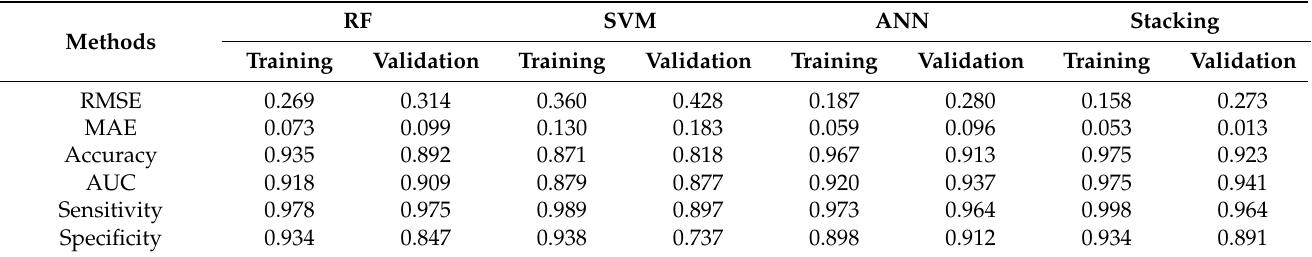
Table 5. Performance evaluation of models for training and validation datasets using statistical